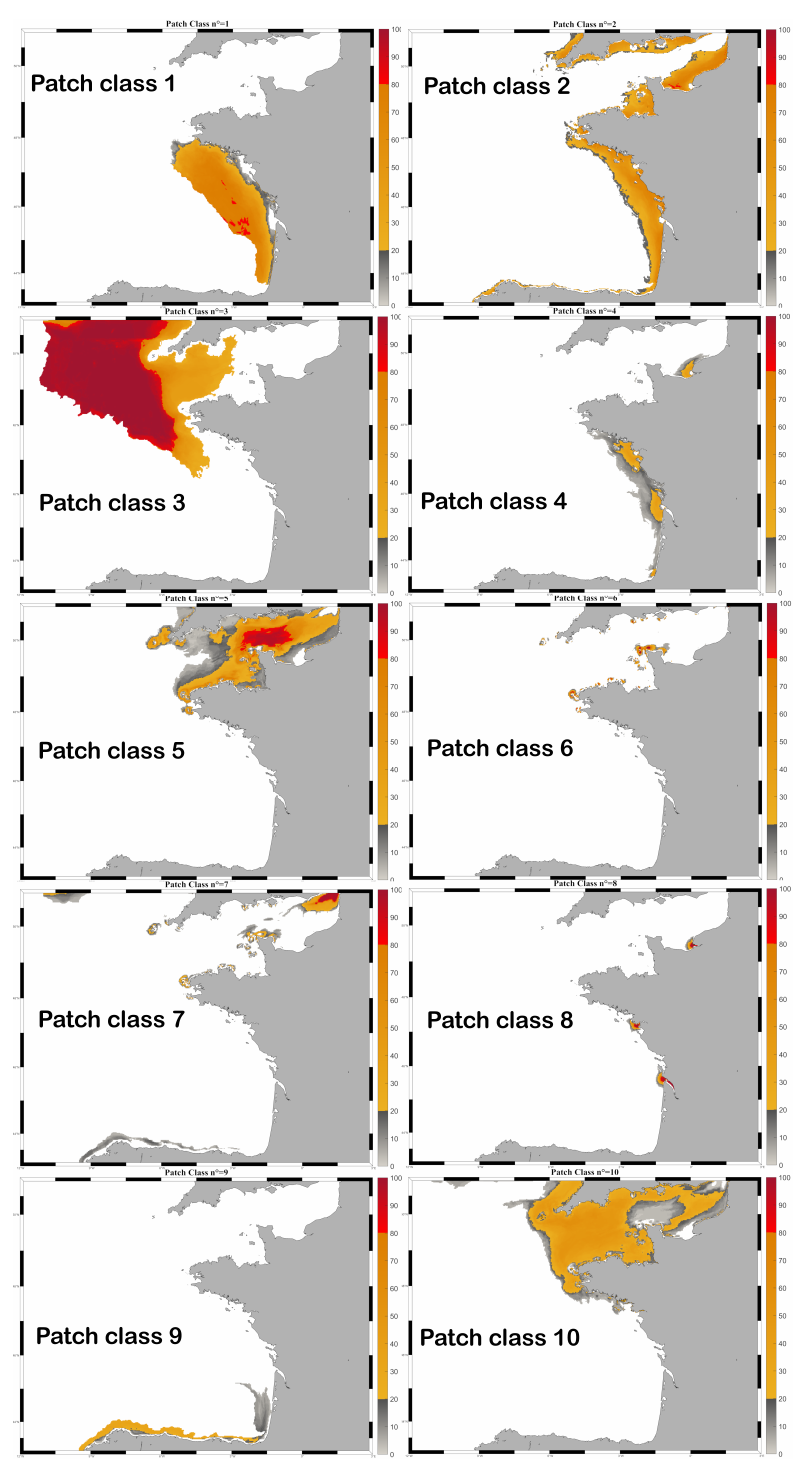
Figure 5. Spatial occurrence of the ten hydrographical patches over the 60 month